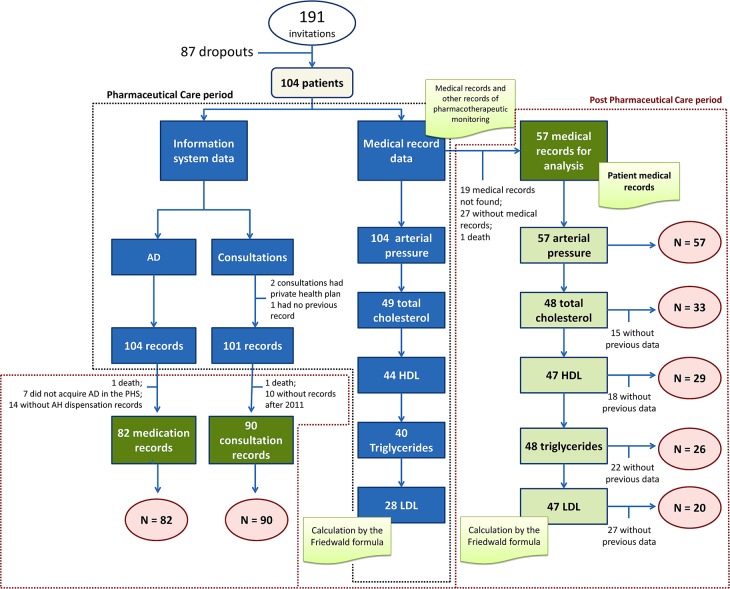
Flowchart of the stratified sample size for each variable analyzed.AD = Antihypertensive Drug; PHS = Public Health System; LDL = Low Density Lipoprotein; HDL = High Density Lipoprotein.